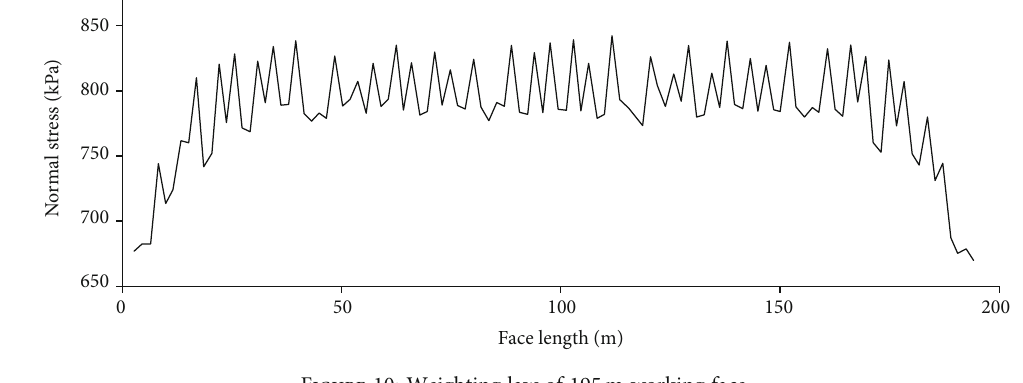
Figure 10: Weighting law of 195m working face.